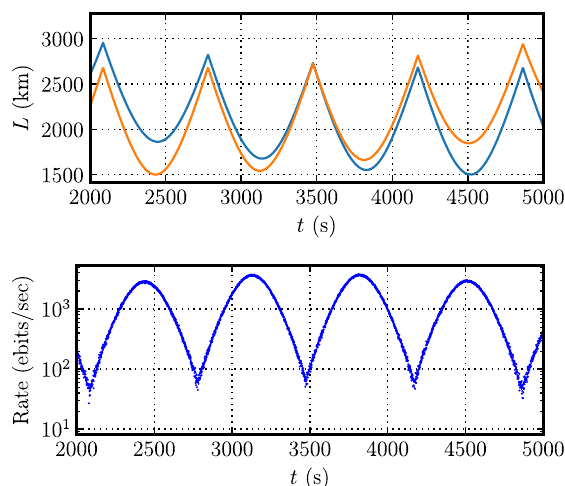
Fig. 4 Entanglement distribution as a function of time to two ground stations at the equator. The ground stations are separated by d = 1000 km with a satellite constellation given by N R = 9 satellite rings, N S = 10 satellites per ring, and altitude h = 1500 km. We show a snapshot from 2000 to 5000 s of our 24-h simulation. Top — the distance L of each ground station to the satellite with the least total transmission loss. Bottom — the corresponding entanglement- distribution rate as a function of time, assuming a source rate of R source = 10 9 ebits/s 100 .